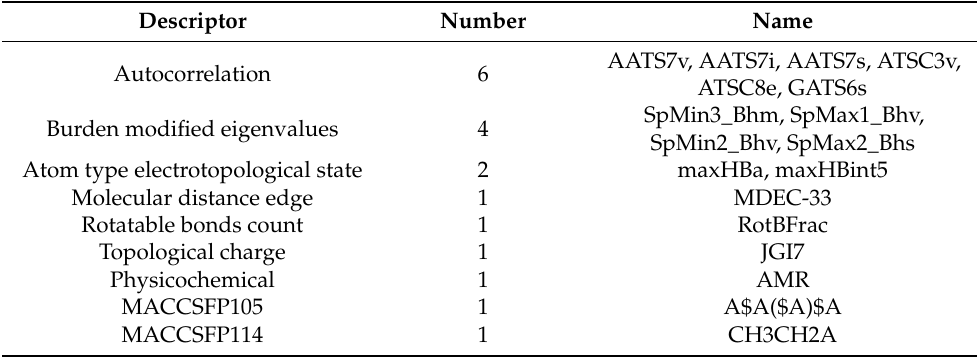
Table 2. Evaluation metrics for binary models.